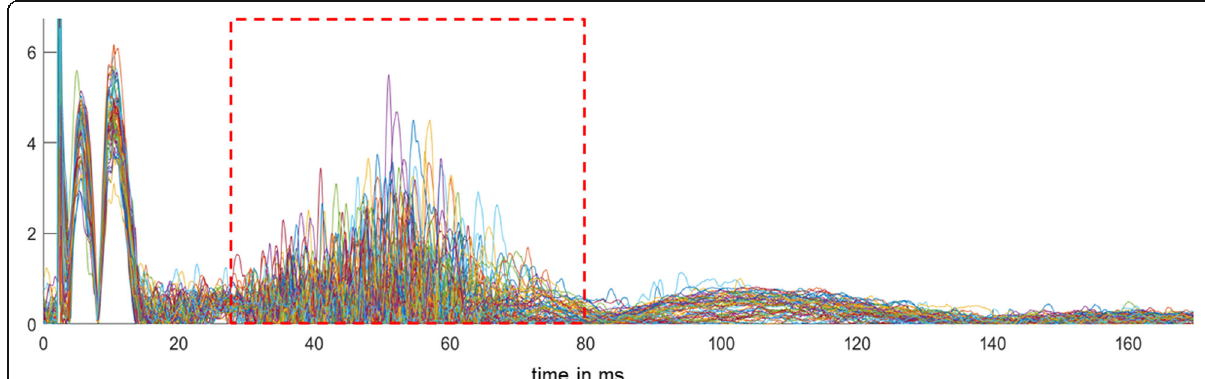
Fig. 1 Superimposed 60 nBR traces of one participant. The R2 component is indicated by a box of red dashed lines between 30-80 ms. Note the stimulation artifact at the start and the immediately following R1 component. The R1 component has a low variability given its monosynaptic pathway through the principal trigeminal nucleus. The R2 component is more variable in amplitude and time given its polysynaptic pathway through the trigemino-cervical complex. The R3 follows the R2 component and starts at about 80-90 ms. Its underlying pathways and functions are still